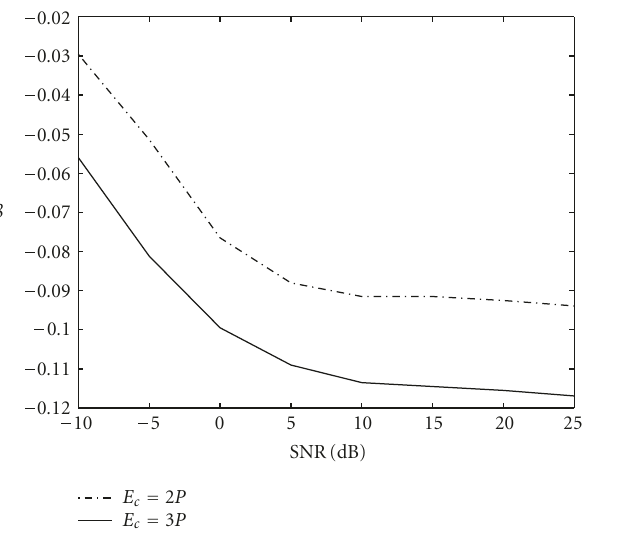
Figure 4: Variation of β with SNR.